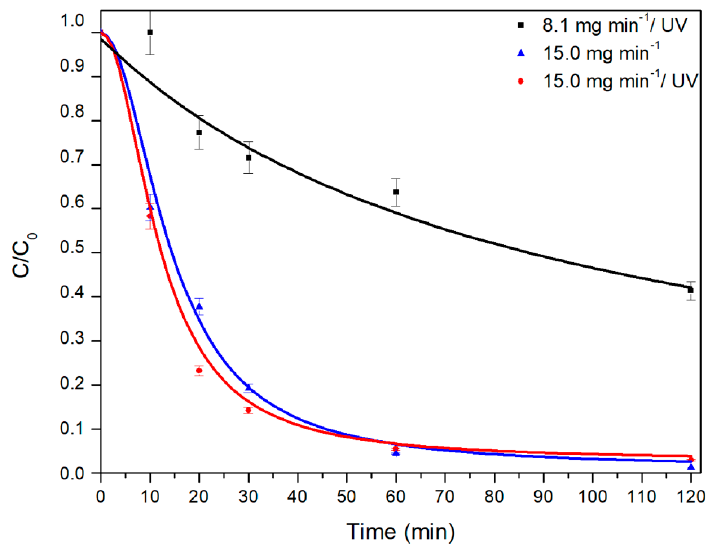
Figure 6. AMX degradation (C/C 0 ) by ozone-based advanced oxidation processes. Experiments carried out at pH 9.00 and temperature control at (20.0 ± 0.5) °C. Feed ozone mass–rate: 8.13 mg min − 1 and 15.00 mg min − 1 .